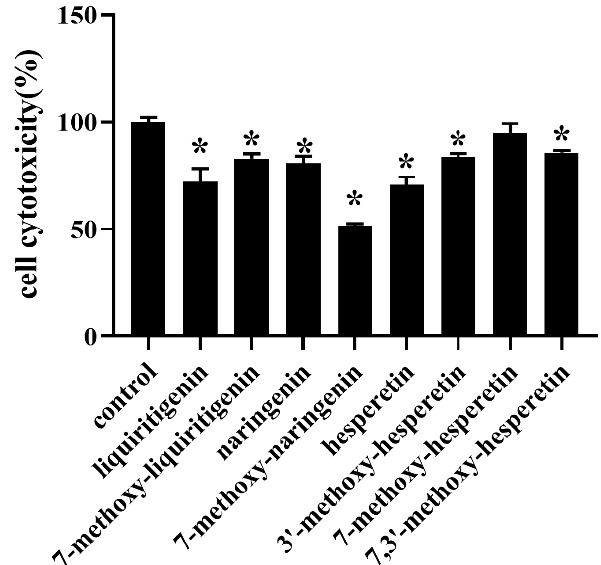
Figure 5. Cytotoxicity of liquiritigenin, 7-methoxy-liquiritigenin, naringenin, 7-methoxynaringenin, hesperetin, 3′ -methoxyhesperetin, 7-methoxyhesperetin, and 7, 3′ -dimethoxyhesperetin on MCF-7 breast cancer cells (mean ± SD, n = 3). Data are presented as mean ± SD. * Indicates a significant difference compared to the control ( p < 0.05).